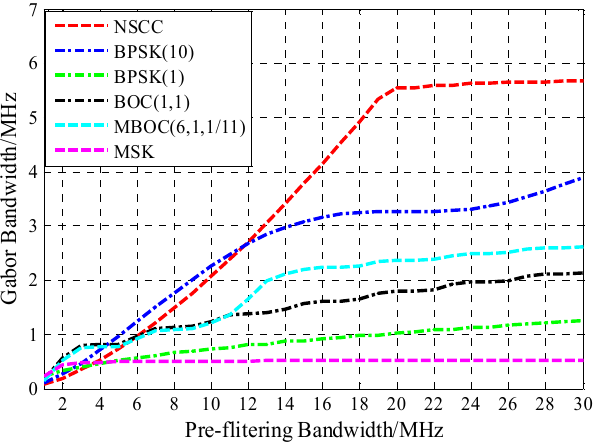
Figure 6. Gabor bandwidth of the legacy navigation signals and NSCC modulation.